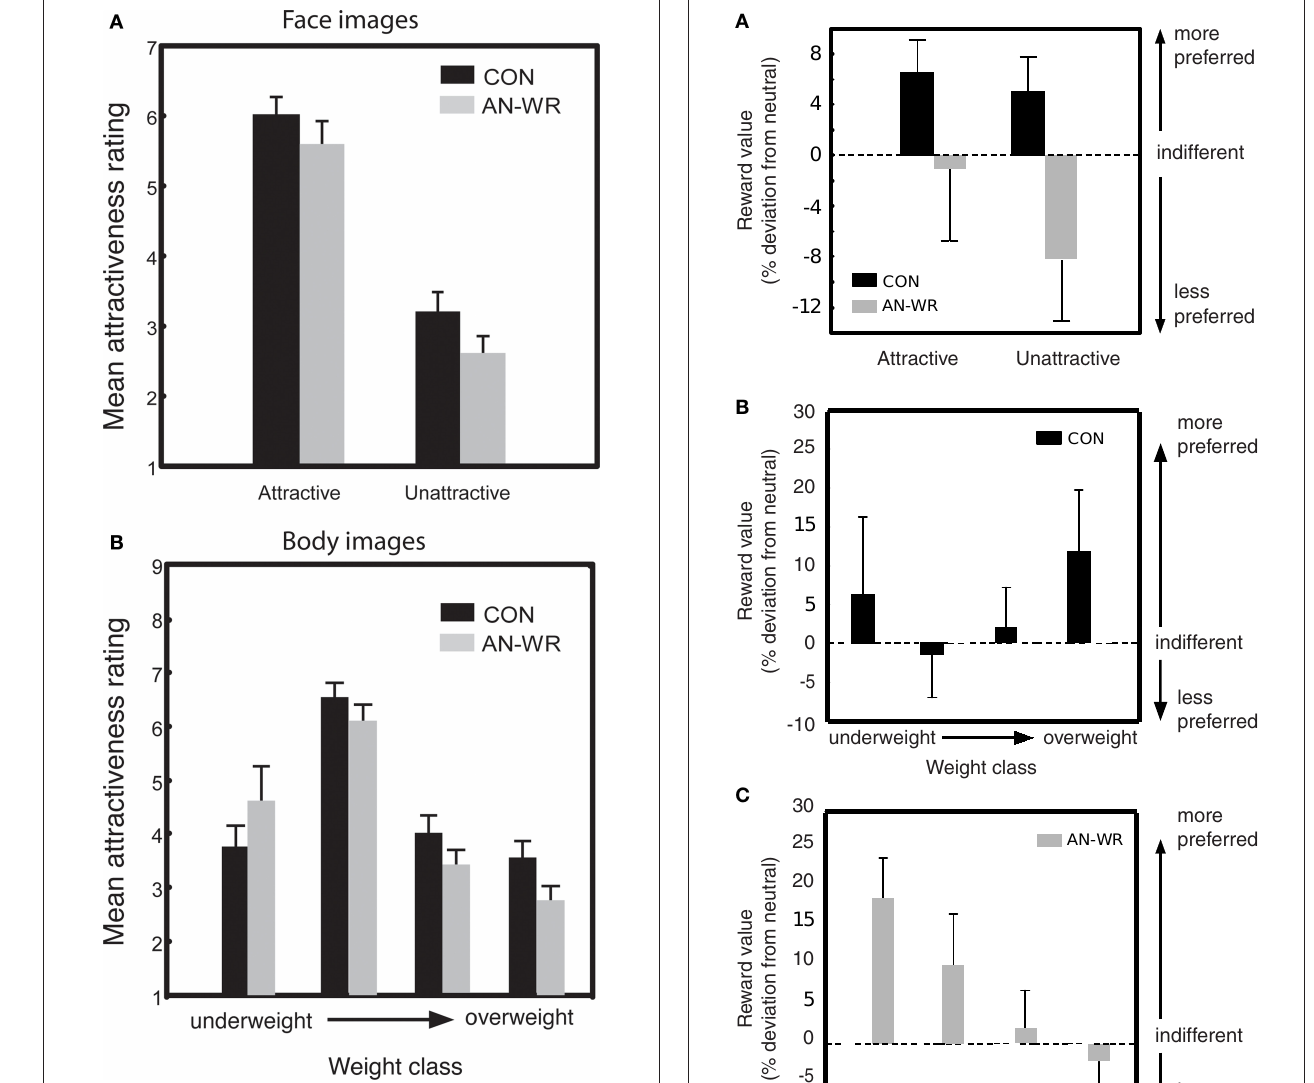
Figure 1 | explicit judgments of attractiveness in anorexia nervosa. (A) Control (CON, black) participants and weight-restored participants with anorexia nervosa (AN-WR, gray) did not differ when asked to rate images of female faces for attractiveness. Canonical “attractive” images were rated higher than “unattractive” images for both groups. (B) Both CON and AN-WR participants rated images of slender-bodied women as significantly more attractive than images of either very overweight or very underweight individuals.